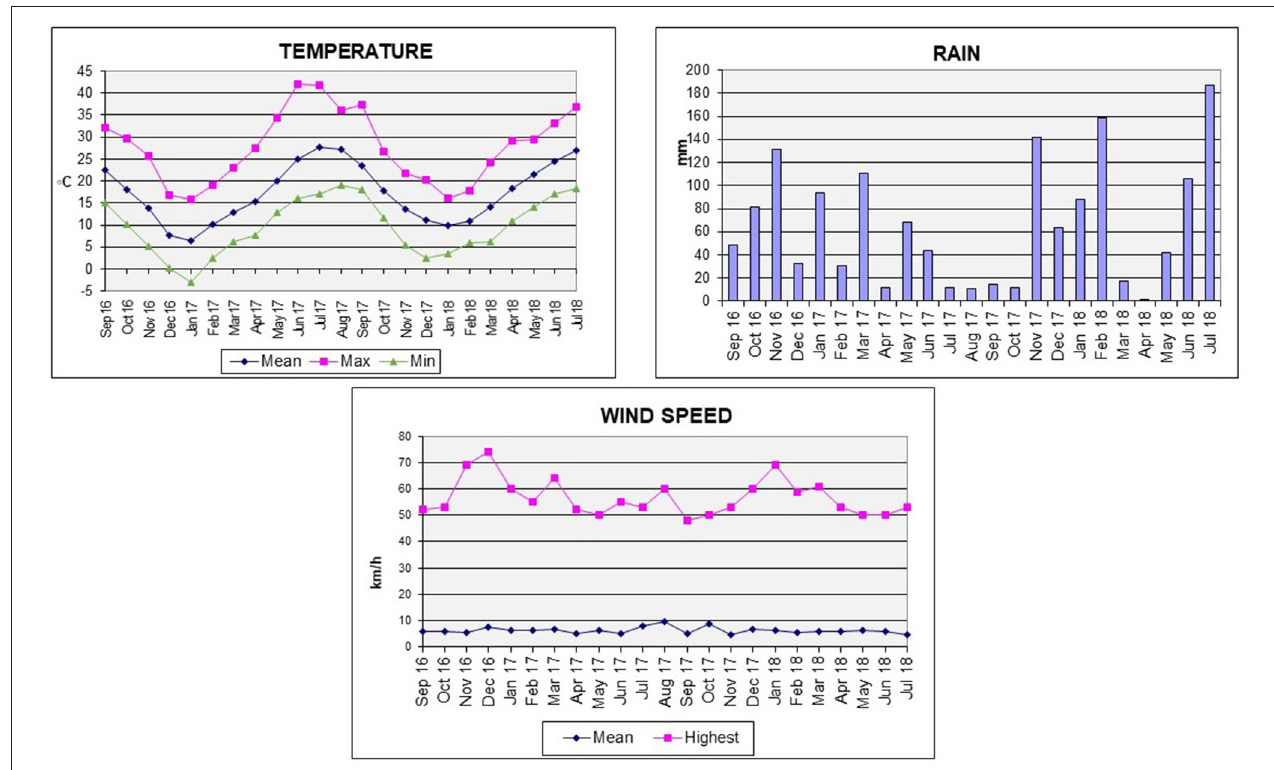
FIGURE 3 | Air temperature, precipitation and wind speed for the experimental period. Source: NOANET Database (Ag. Paraskevi meteo station); http://meteosearch.